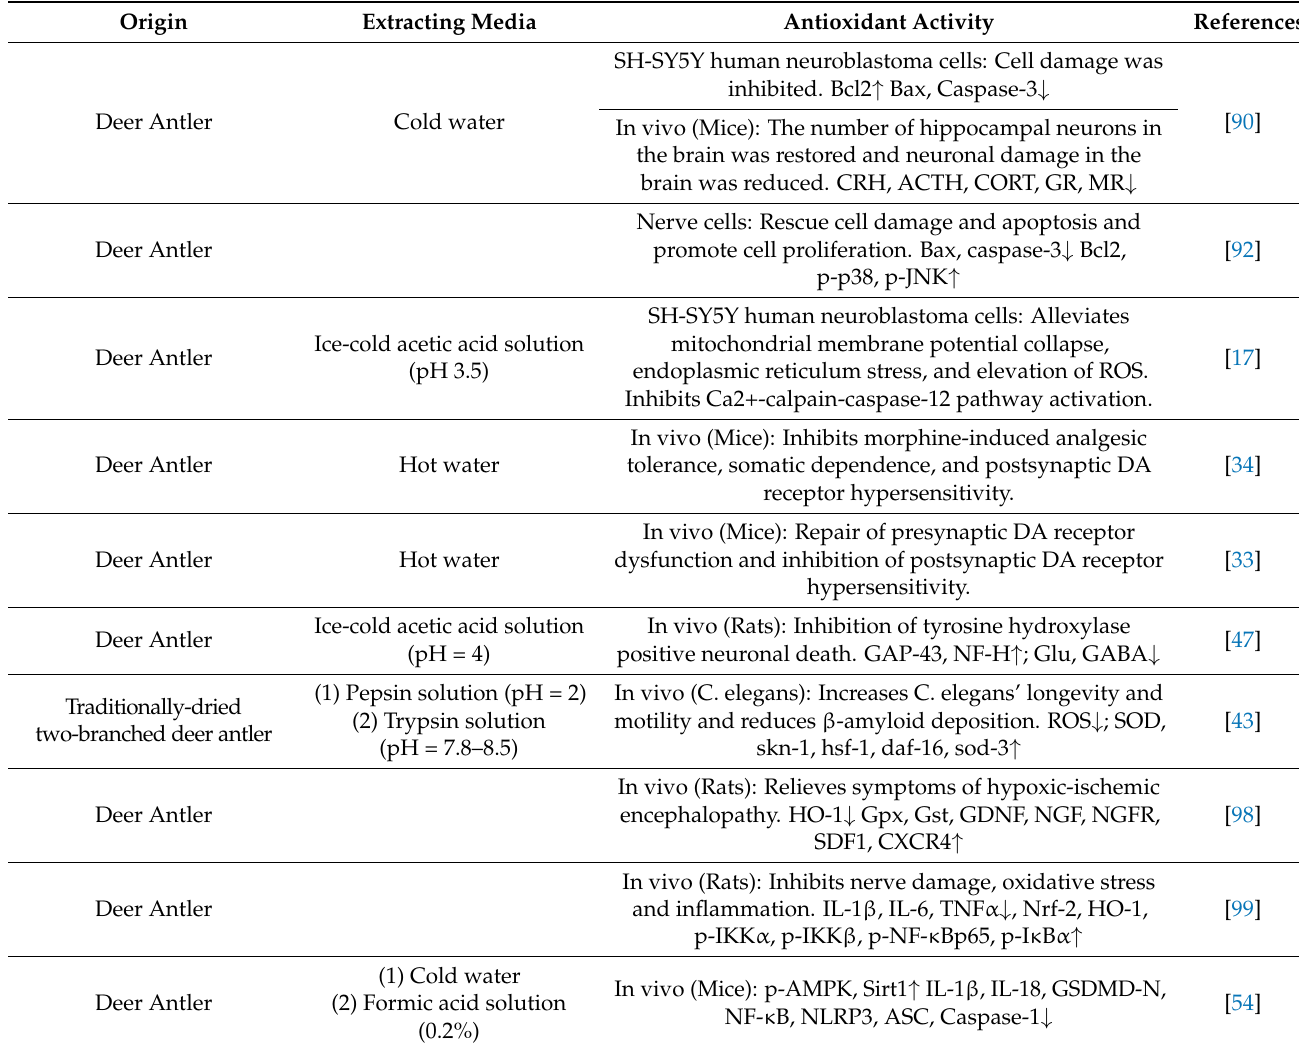
Table 6. Effects of DAPs on neurological